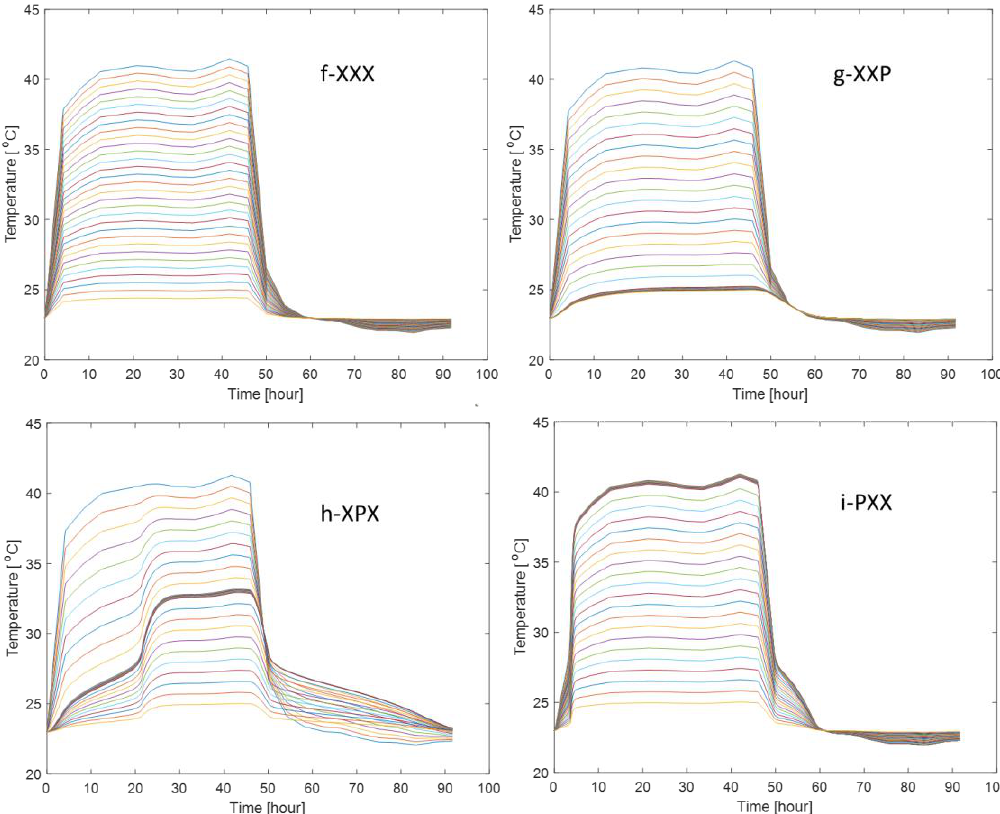
Figure 13. Simulation results of three-layer wall configurations f–i as shown in Figure 3. X: stands for XPS; P: stands for PCM. The lumped curves are temperature profiles over the PCM layer; other curves are temperature profiles over the XPS layer in every tenth of the thickness.